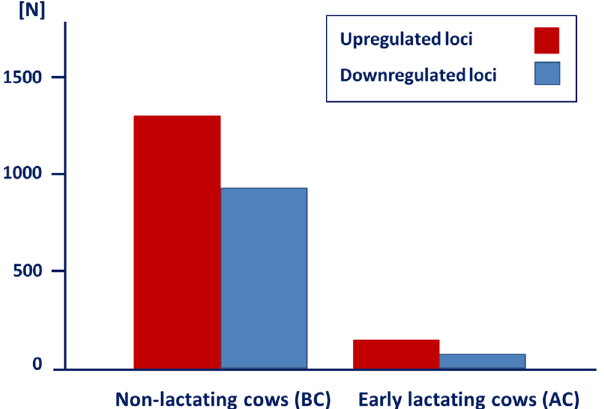
Fig 2. Number of differentially expressed loci in cows vaccinated prior to and after calving. N: Number of differentially expressed transcripts, BC: Cows vaccinated prior to calving, non-lactating. AC: Cows vaccinated prior to calving, early